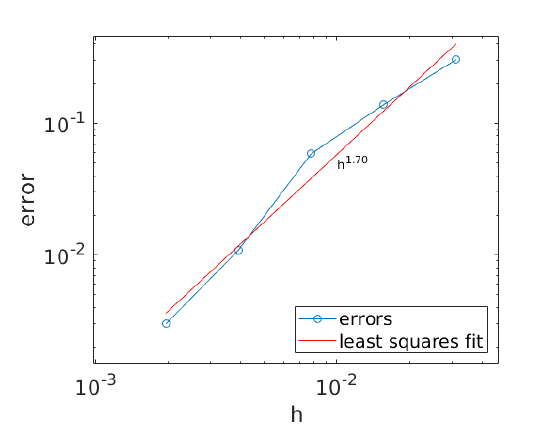
Figure 9. The ResNet-ROM rate of convergence with respect to the meshsize h .